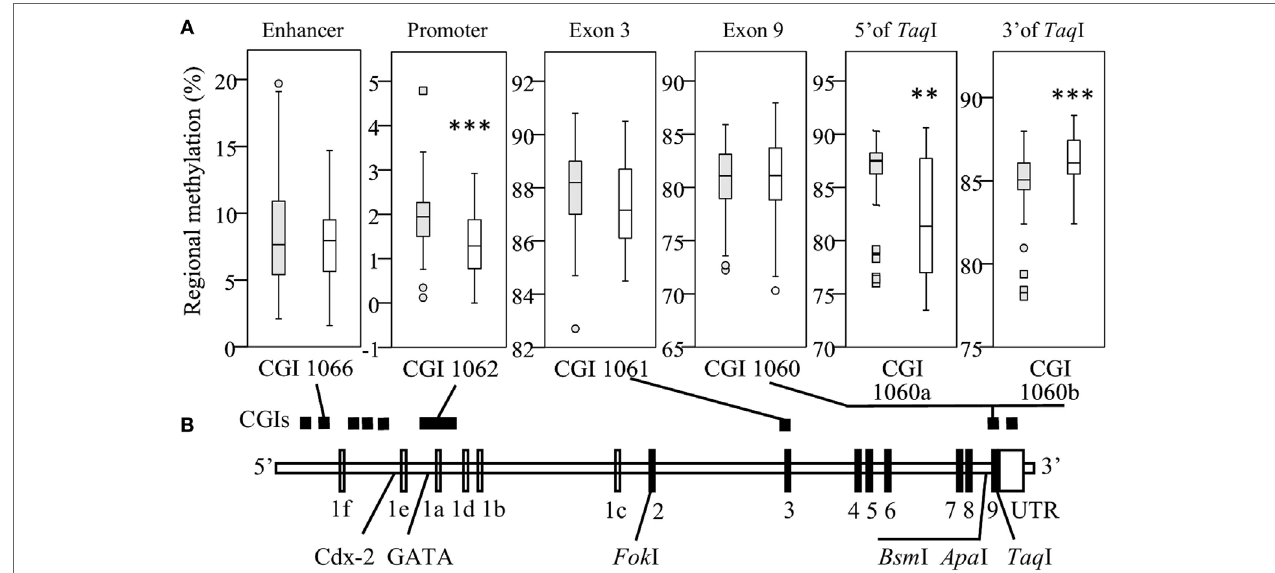
FigUre 2 | Race differences in regional vitamin D receptor ( VDR ) methylation. Box-and-whisker plots show the spread of regional methylation, quantified by bisulfite pyrosequencing, at the selected CpG islands (CGIs) (a) in context of VDR non-coding (unfilled) and coding exons (filled) and key single-nucleotide polymorphisms (B) ; CGI 1066 spanning an enhancer, 1062 the primary promoter, 1061 exon 3 and 1060 exon 9, and the promoter of a non-coding transcript. Compared to Black South Africans (filled boxes, n = 50), methylation in Whites (open boxes, n = 50) was significantly lower in CGI 1062 (*** P < 0.001) and 1060a (** P < 0.010), but higher in CGI 1060b (*** P < 0.001). Box-and-whisker plots show the median (line in box), interquartile range (IQR, height of box), 95% CI (whiskers, extending to 1.5 IQRs or minimum and maximum values if no case has a value in that range), outliers ( ○ , between 1.5 IQRs and 3 IQRs from the end of a box), and extreme outliers ( ◻ , more than 3 IQRs from the end of a box). Site-specific methylation is shown in Figures S5A–D in Supplementary Material.